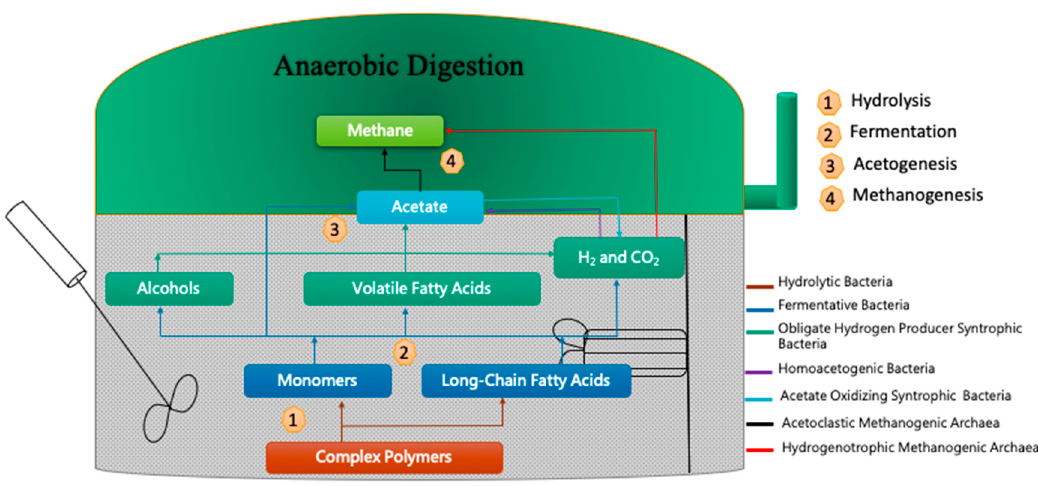
Figure 3. Steps and microorganisms involved in biogas